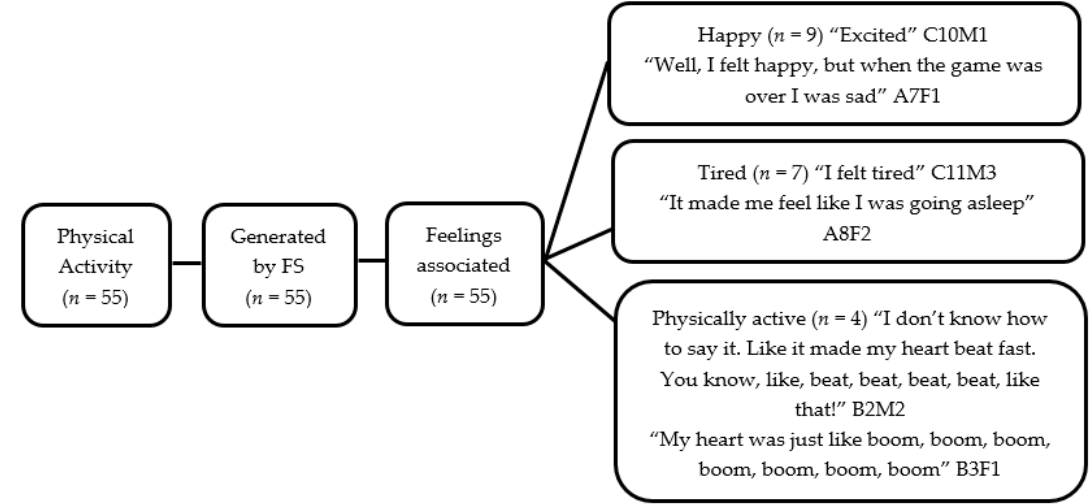
Figure 7. Pen profile demonstrating PA generated by FS and associated feelings.